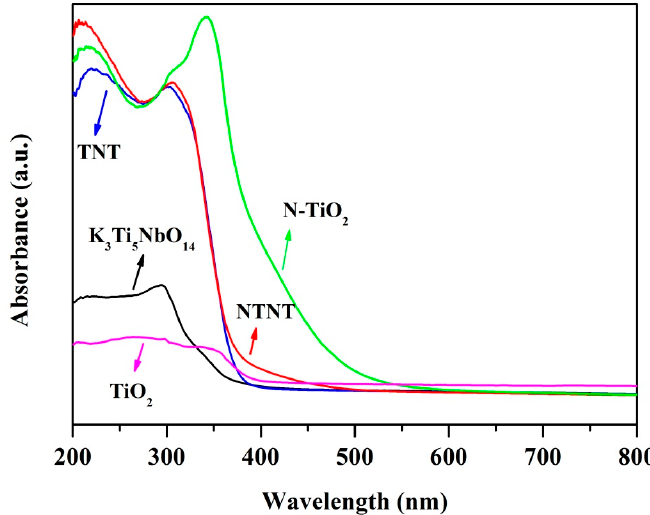
Figure 5. UV-Vis diffuse reflectance spectra (DRS) of K 3 Ti 5 NbO 14 , TNT, NTNT, TiO 2 , and N–TiO 2.